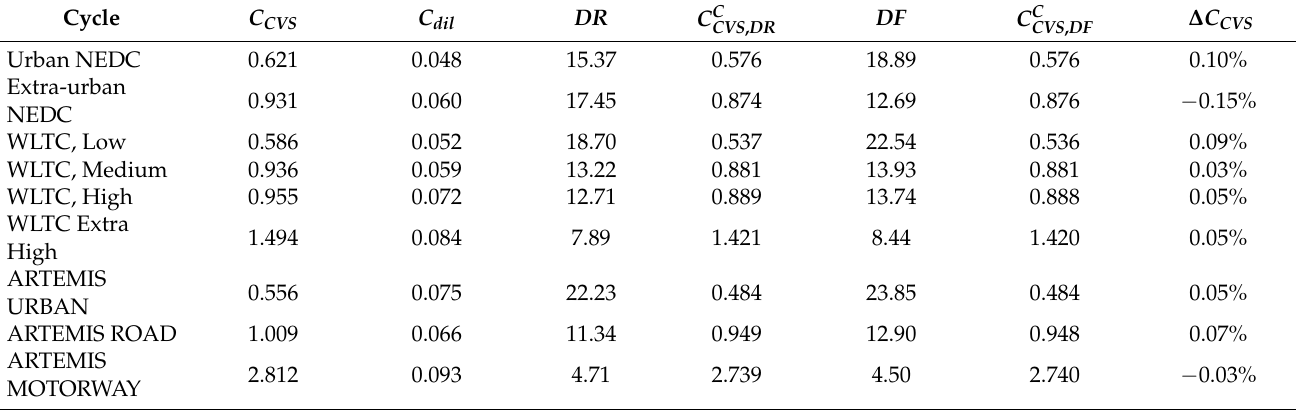
Table A6. The C CVS,corr calculated based on Equations (5) and (21) for Euro 6 NEDC vehicle with SI engine, CO 2 concentration